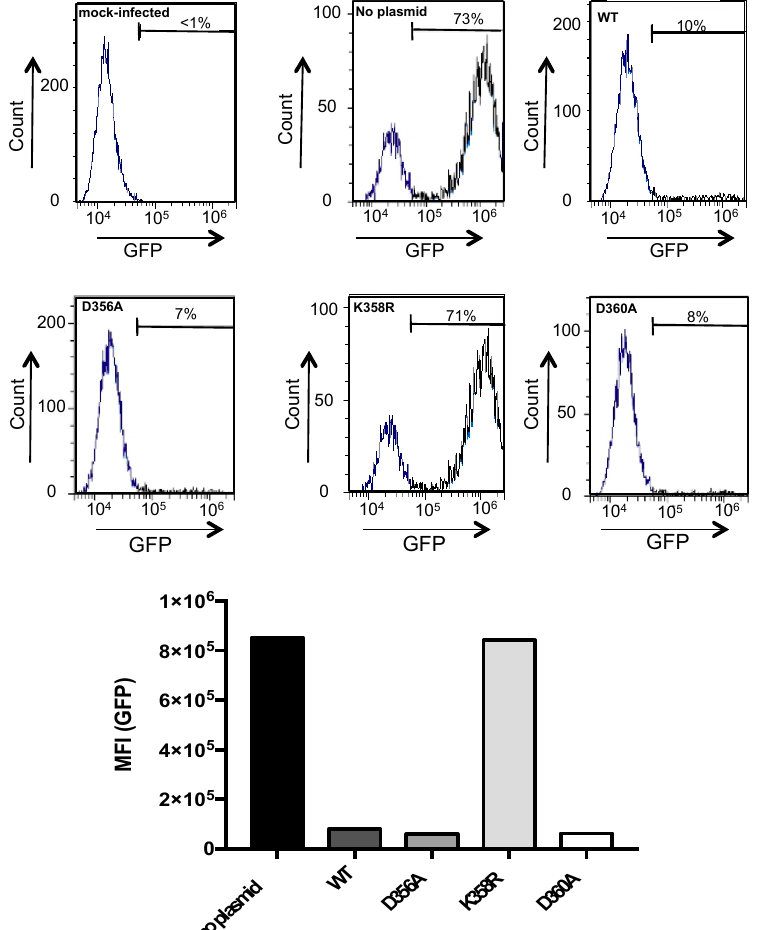
Figure 6. Antiviral action of mutant rVPs against ZIKV replication. A549 cells were transfected 18 h with plasmids expressing rVP wt , rVP-D356A, rVP-K358R, or rVP-D360A or mock-transfected (no plasmid). Cells were infected 24 h with ZIKV GFP at MOI of 2. The percentage of GFP-positive cells and the MFI were determined by FACS